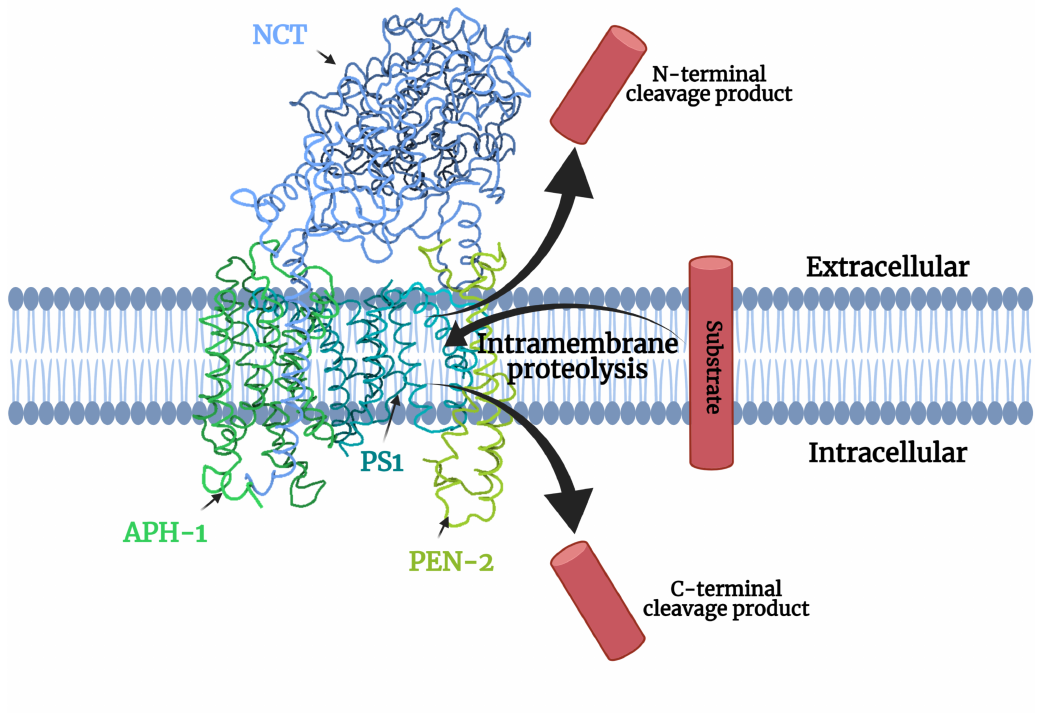
Figure 1. Components of gamma-secretase processing a transmembrane substrate. (PDB ID: 5A63 from